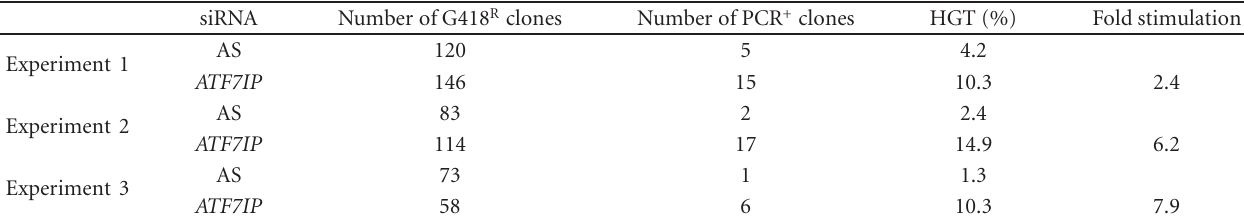
Table 2: E ff ect on gene targeting at the XPC4 locus of an siRNA targeting the ATF7IP gene.